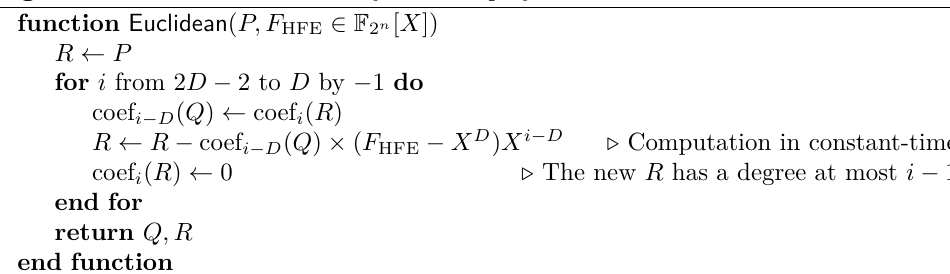
Algorithm 8 Euclidean division by a monic